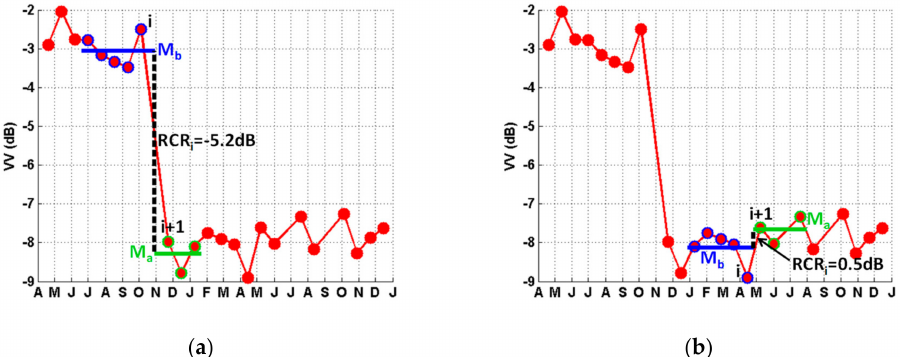
Figure 8. Temporal variation of the VV backscatter in an area detected as a new shadow (red), and illustration of the calculation of the change indicator RCR i (radar change ratio) for X b = 5 and X a = 3 for two pairs of dates: ( a ) the exact date interval during which change occurs; ( b ) a date interval when no change